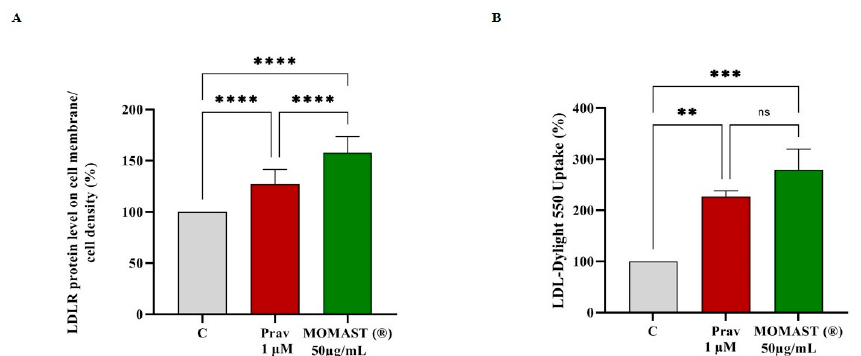
Figure 4. HepG2 cells were treated with MOMAST ® (50.0 µ g/mL) and Pravastatin (Prav) 1.0 µ M for 24 h. The percentage of LDLR protein level was measured by ICW (Panel ( A )). The data points represent the averages ± SD of three experiments in duplicate. (****) p < 0.0001 vs. control (C). (Panel ( B )) Effect of MOMAST ® on the HepG2 cell ability to uptake LDL. The data points represent the averages ± SD of three experiments in triplicate. ns: not significant, (**) p < 0.01, and (***) p < 0.001 vs. control (C). LDLR: low-density lipoprotein receptor, LDL: low-density